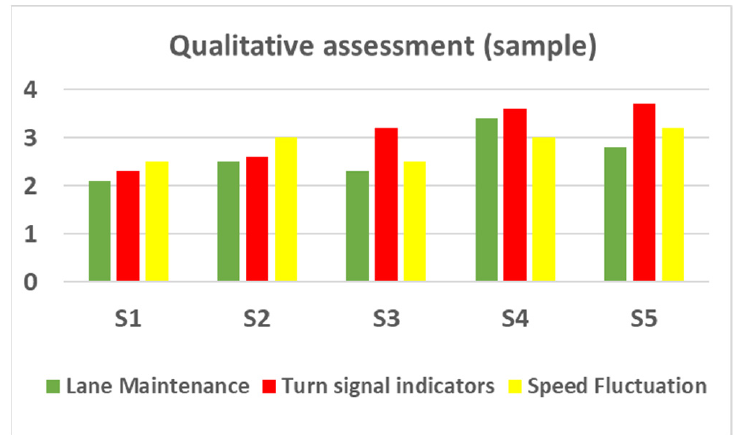
Figure 13. Sample instructor evaluation (qualitative).